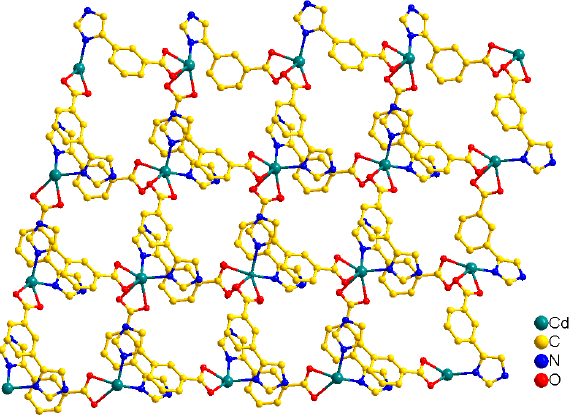
Figure 2. 2D layered structure of 1 .